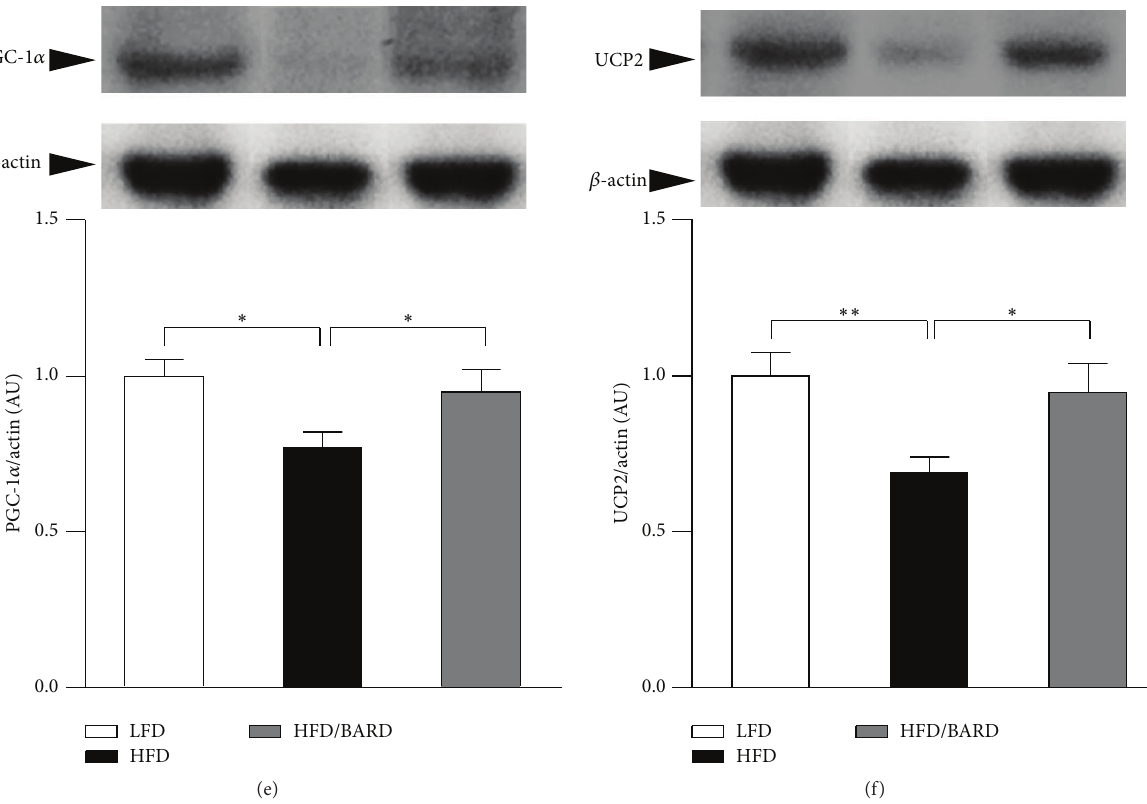
Figure 5: Effect of bardoxolone methyl (BARD) on expression of rate limiting enzyme, 𝛽 3 -AR, PGC-1 𝛼 , and UCP2 in mesenteric adipose tissue of mice fed low-fat diet (LFD), high-fat diet (HFD), and high-fat diet supplemented with BARD (HFD/BARD). (a) Representative blots and protein level of TH. (b) Representative blots and protein level of pTH. (c) pTH/TH ratio. (d) Representative blots and protein level of 𝛽 3 -AR. (e) Representative blots and protein level of PGC-1 𝛼 . (f) Representative blots and protein level of UCP2. All data are expressed as mean ± SEM. ∗ 𝑝 < 0.05 ; ∗∗ 𝑝 < 0.01 . TH: tyrosine hydroxylase, pTH: phosphorylated TH; 𝛽 3 -AR: 𝛽 3 -adrenergic receptor; PGC-1 𝛼 : peroxisome proliferator-activated receptor gamma coactivator 1-alpha; UCP2: uncoupling protein 2; AU: arbitrary unit.